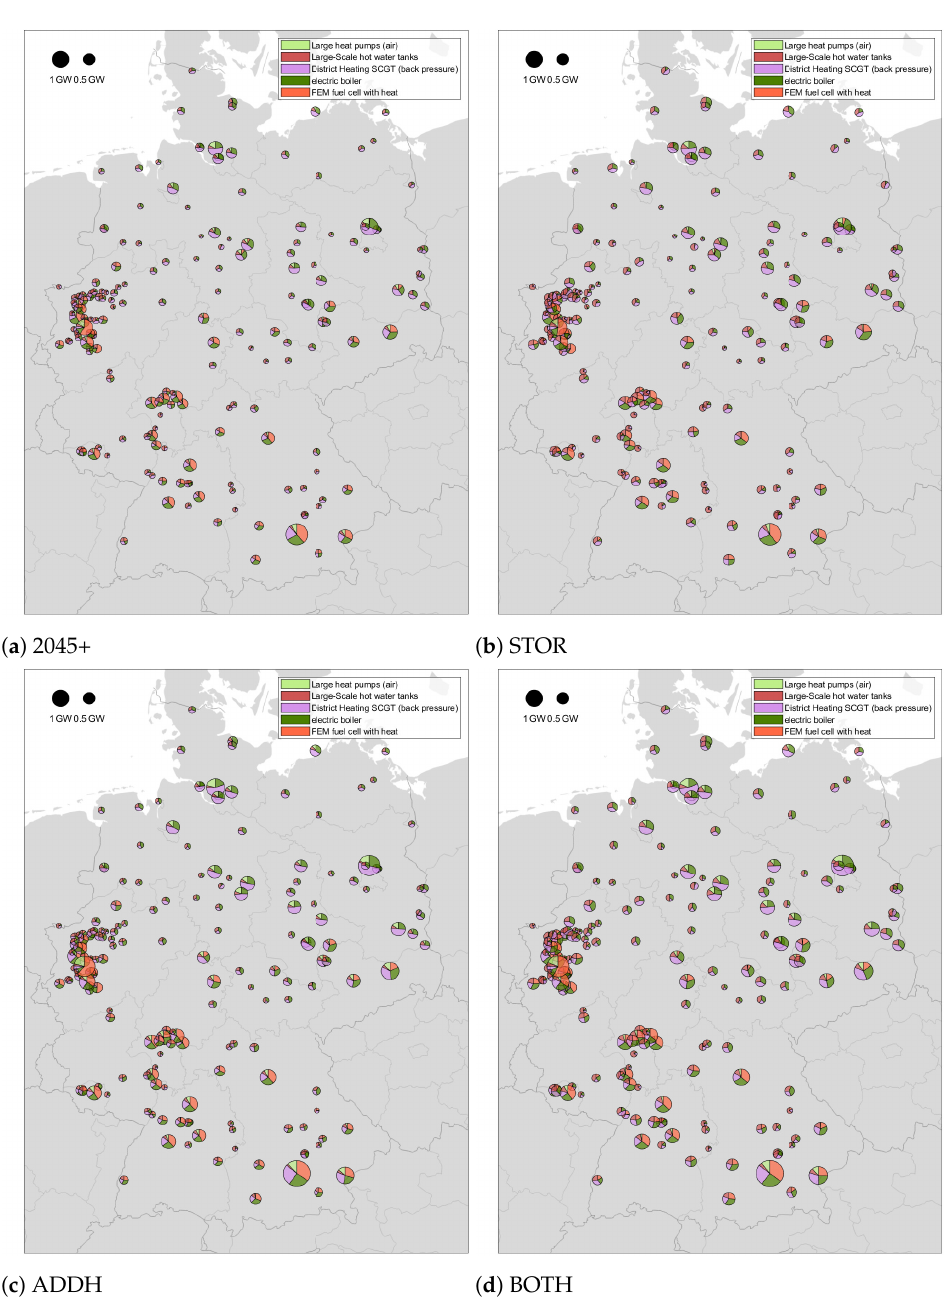
Figure A2. Expansion of district heating technologies in the four